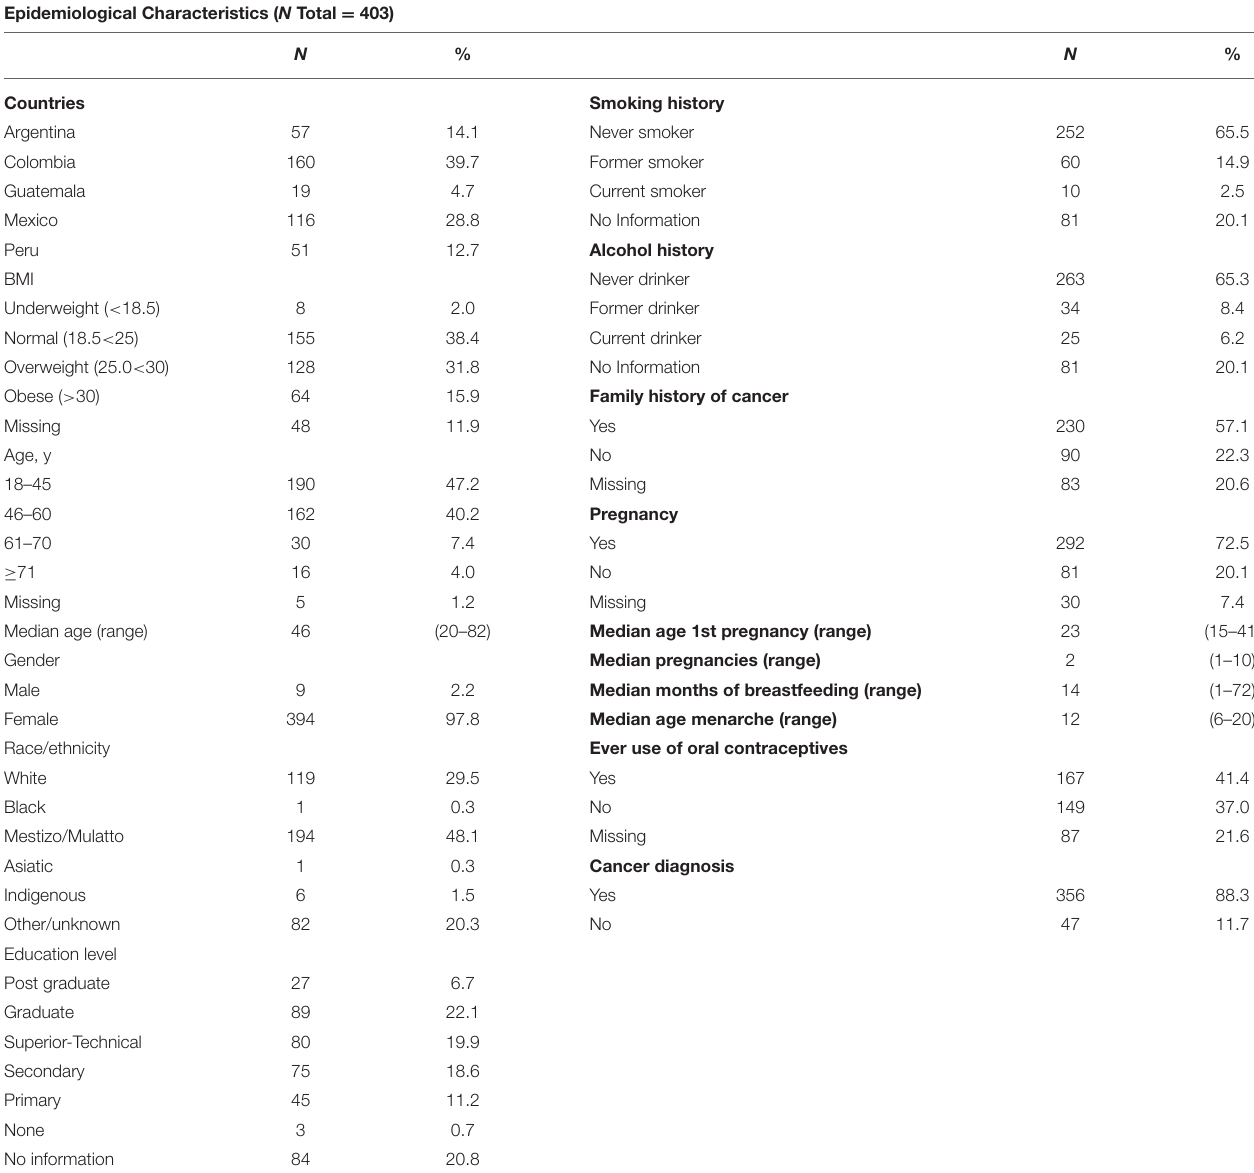
TABLE 1 | Epidemiological characteristics of the 403 individuals recruited in the first phase of the LACAM study. Epidemiological Characteristics ( N Total = 403) N %